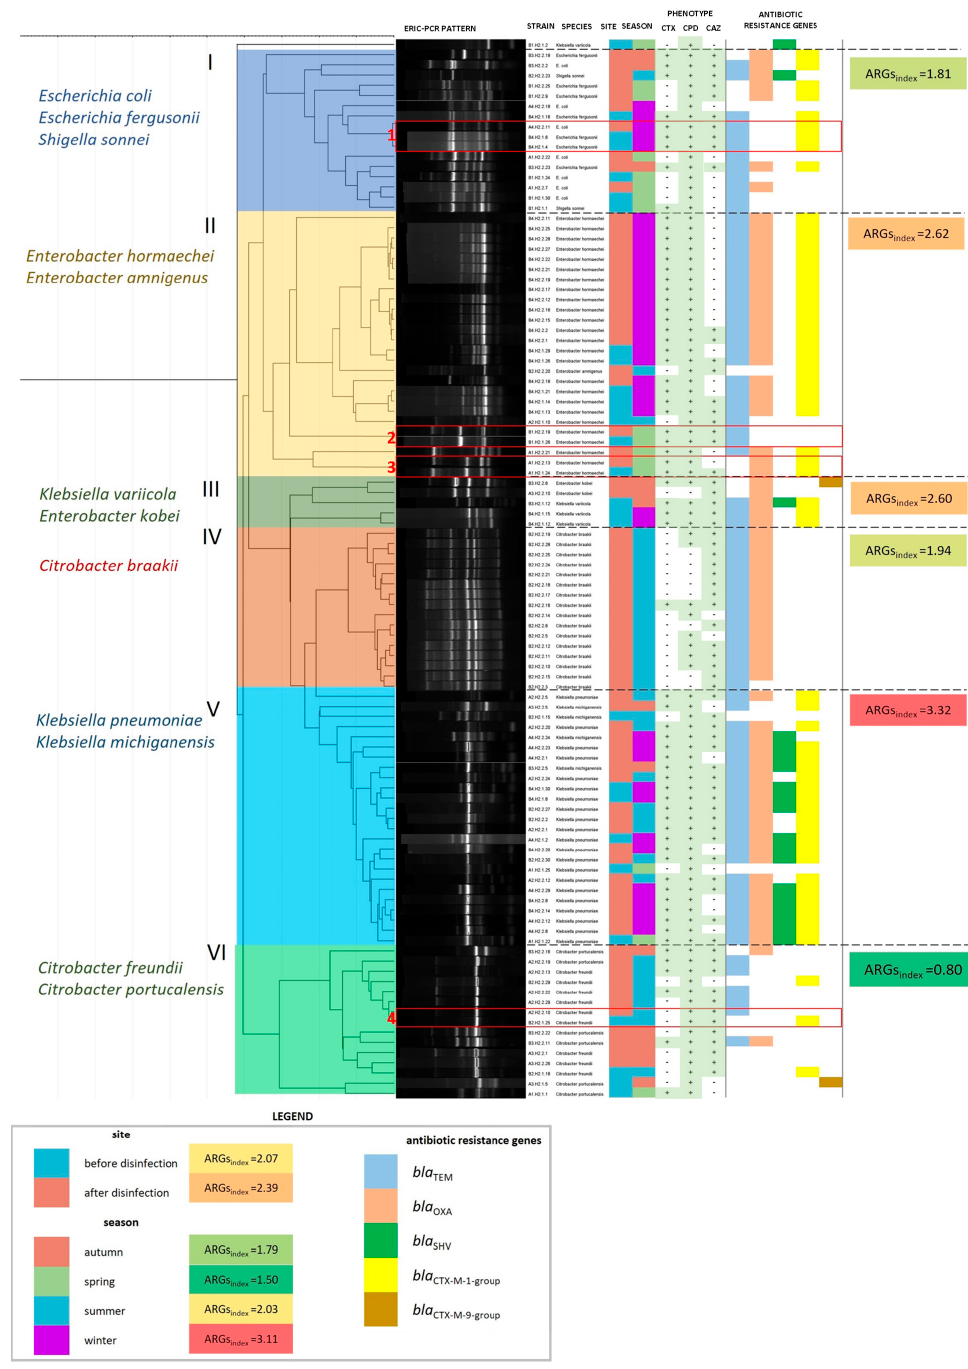
Figure 5. A dendrogram based on the similarity matrix of ERIC-PCR patterns in 104 ESBL+ isolates (similarity method: Pearson’s correlation coefficient; linkage method: UPGMA). The dendrogram was divided into six clusters with different species composition (cluster numbers and species names are presented on the left side of the dendrogram). Strain characteristics are presented on the right side of the dendrogram: isolate identifier, species, site and season of isolation, phenotypic characteristics of ESBLs, and the presence of ARGs. The ARG index was calculated for each cluster, season, and sampling site as the mean number of ARGs per bacterial isolate in each group. ESBL+ isolates from different sampling sites, characterized by identical ERIC-PCR profiles, are presented in subgroups in red boxes and are numbered from 1 to